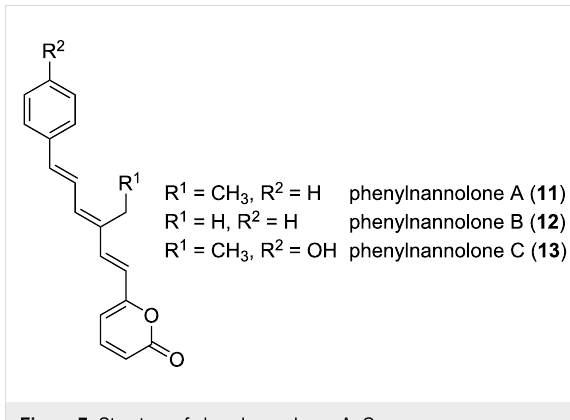
Figure 7: Structure of phenylnannolones A–C. ATP-binding cassette transporter (ABC transporter). In tumor cells, P-gp serves as an efflux transporter of drugs, ultimately leading to treatment failure